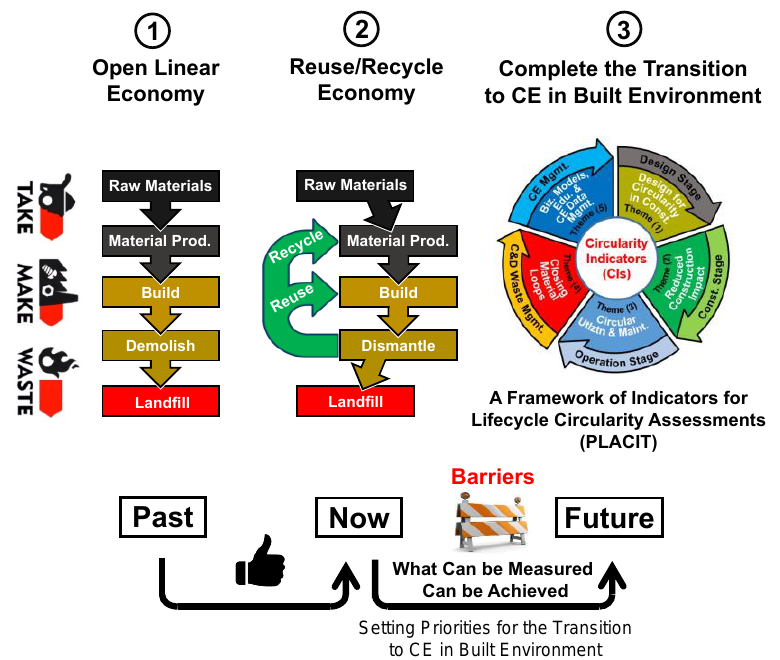
Figure 9. Partial transition and need to reset priorities to complete the transition to CE in built